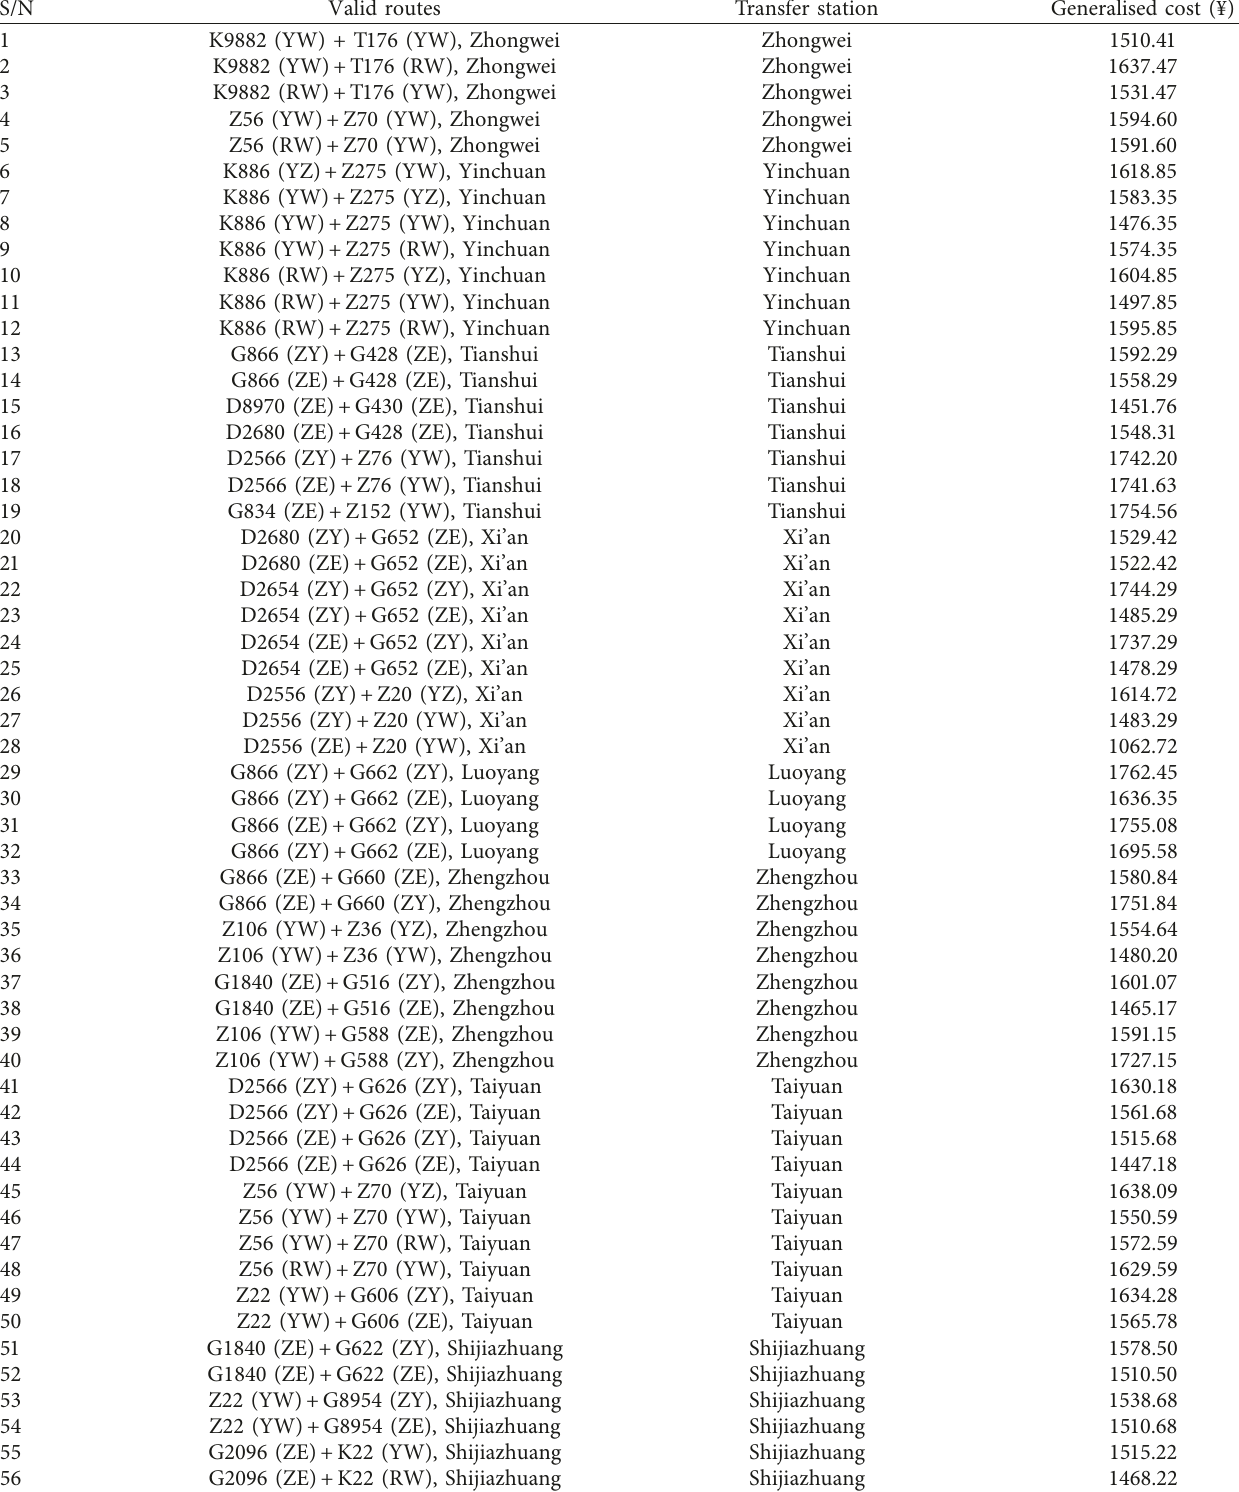
Table 5: Part transfer valid